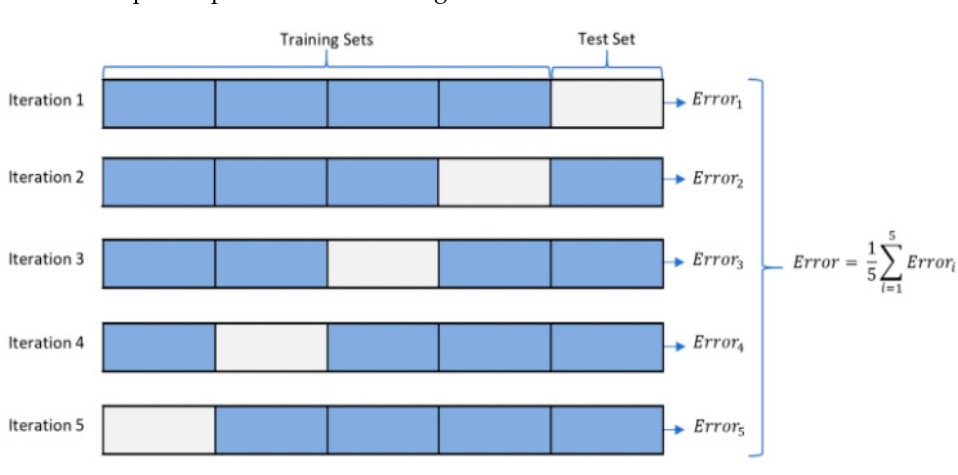
Figure 5. Concept of cross